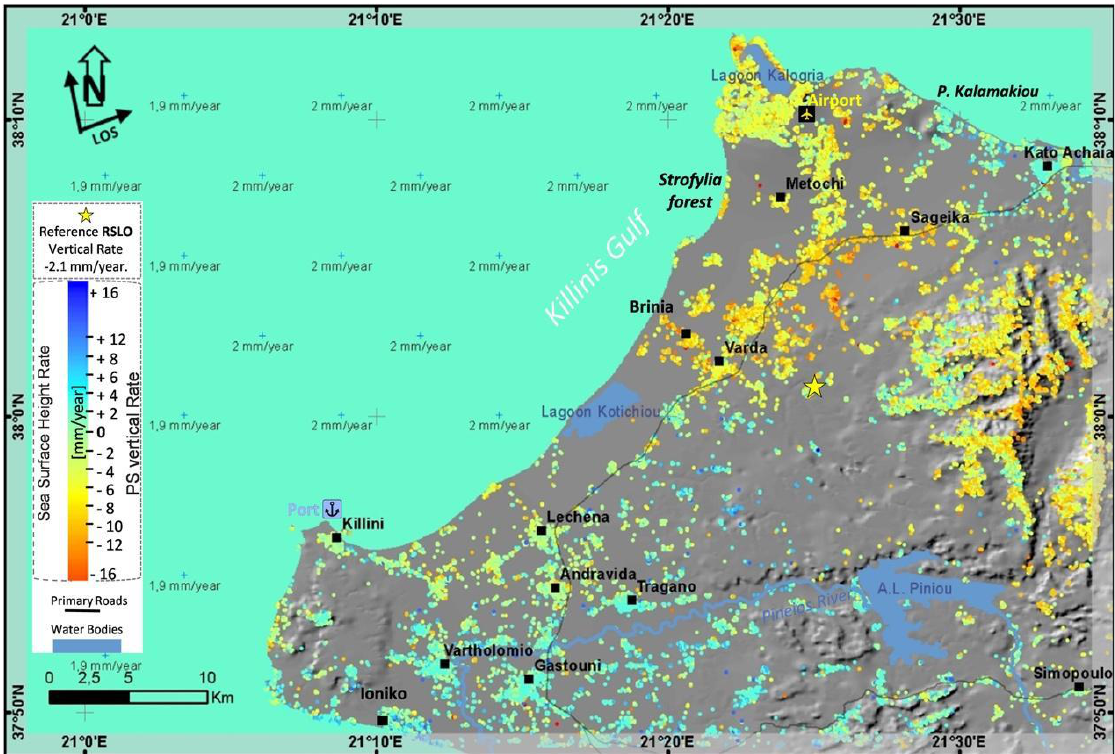
Figure 6. Vertical land deformation rate and sea-surface height rate map of the Killini, Araxos coastal area in the northwestern Peloponnese. PS stands for permanent scatterers